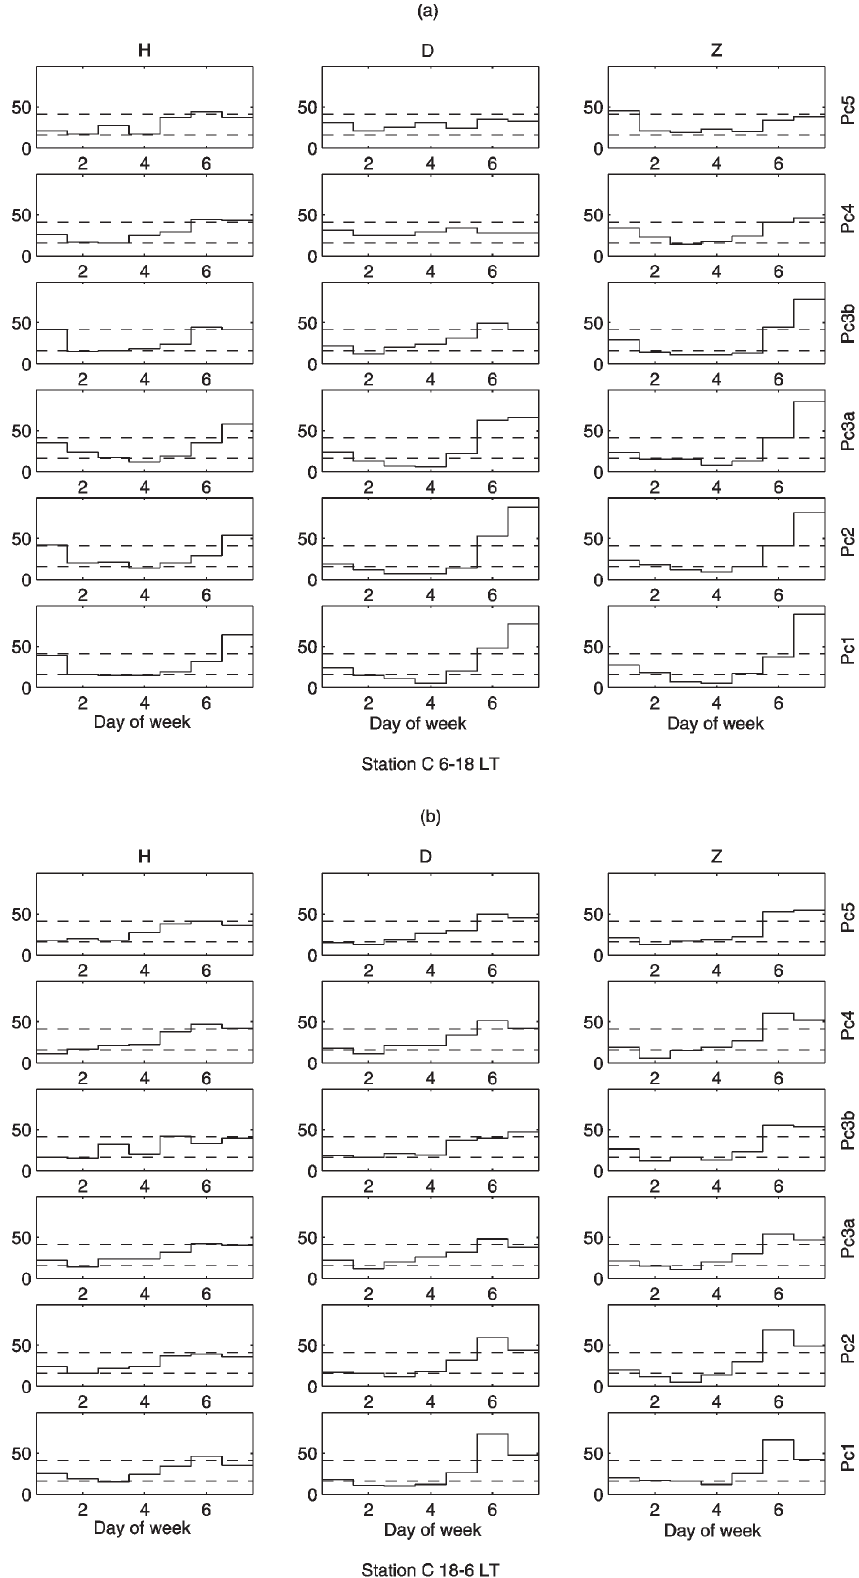
Fig. 5. Weekly distribution of the lowest values of power (5% of the whole population) in different frequency bands at Station C. Dashed lines identify the 99% confidence interval. (a) daytime interval; (b) nighttime